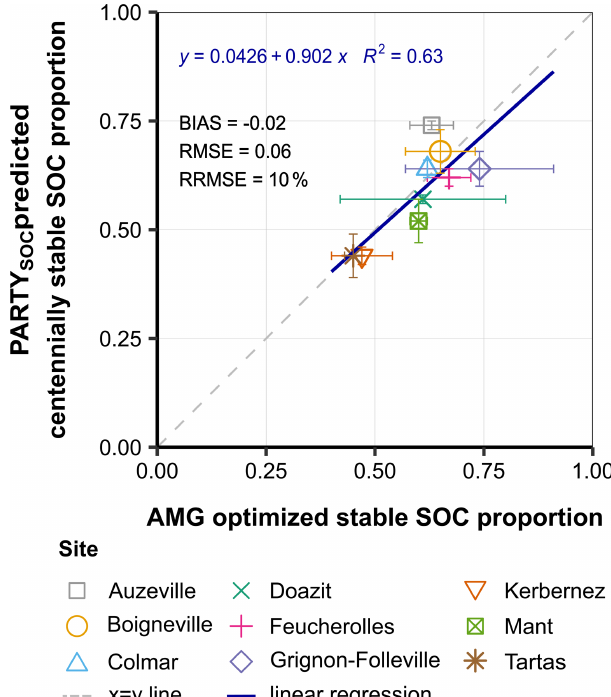
Figure 1. Performance of the PARTY SOC model to predict the cen- tennially stable-SOC proportion compared to the ex post AMG- optimized stable-SOC proportion. Points represent site-mean values based on initial topsoil samples from nine independent French long- term experiments. Statistics refer to the linear regression between x and y values (blue solid line). Horizontal error bars show the un- certainty associated with the AMG-optimal stable-SOC proportion, calculated as the standard deviation of treatment-wise AMG opti- mizations. Vertical error bars represent the prediction error of the centennially stable-SOC proportion values, calculated as the stan- dard deviation of the PARTY SOC model predictions on initial top- soil